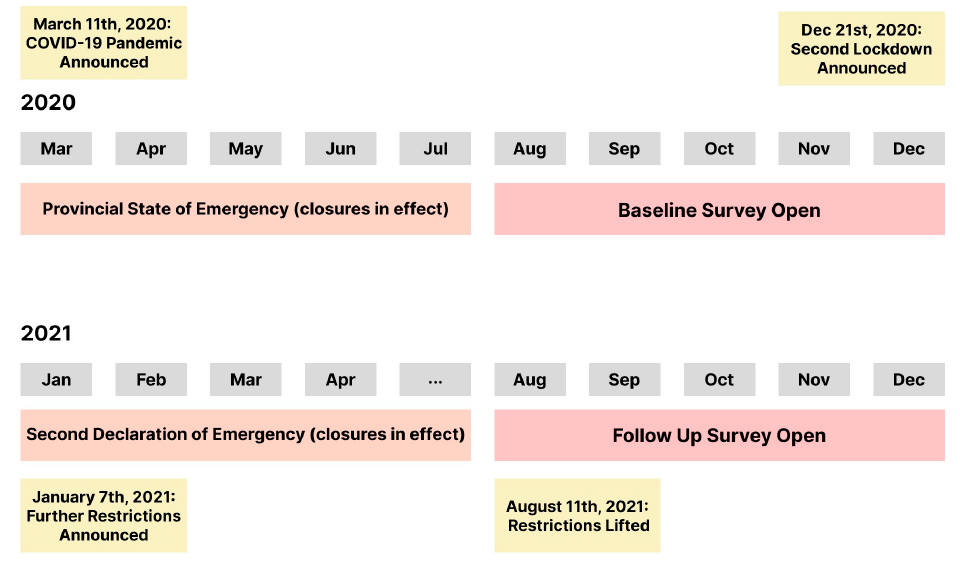
Figure 1. Timeline of the Return to Play Study Surveys and Provincial Mandates. Note: During closures and policies were in effect, including, but not limited to, stay-at-home periods, school closures, non-essential business closures (e.g., restaurants, gyms), and remote (work from home) work mandates for non-front line staff workers [15].